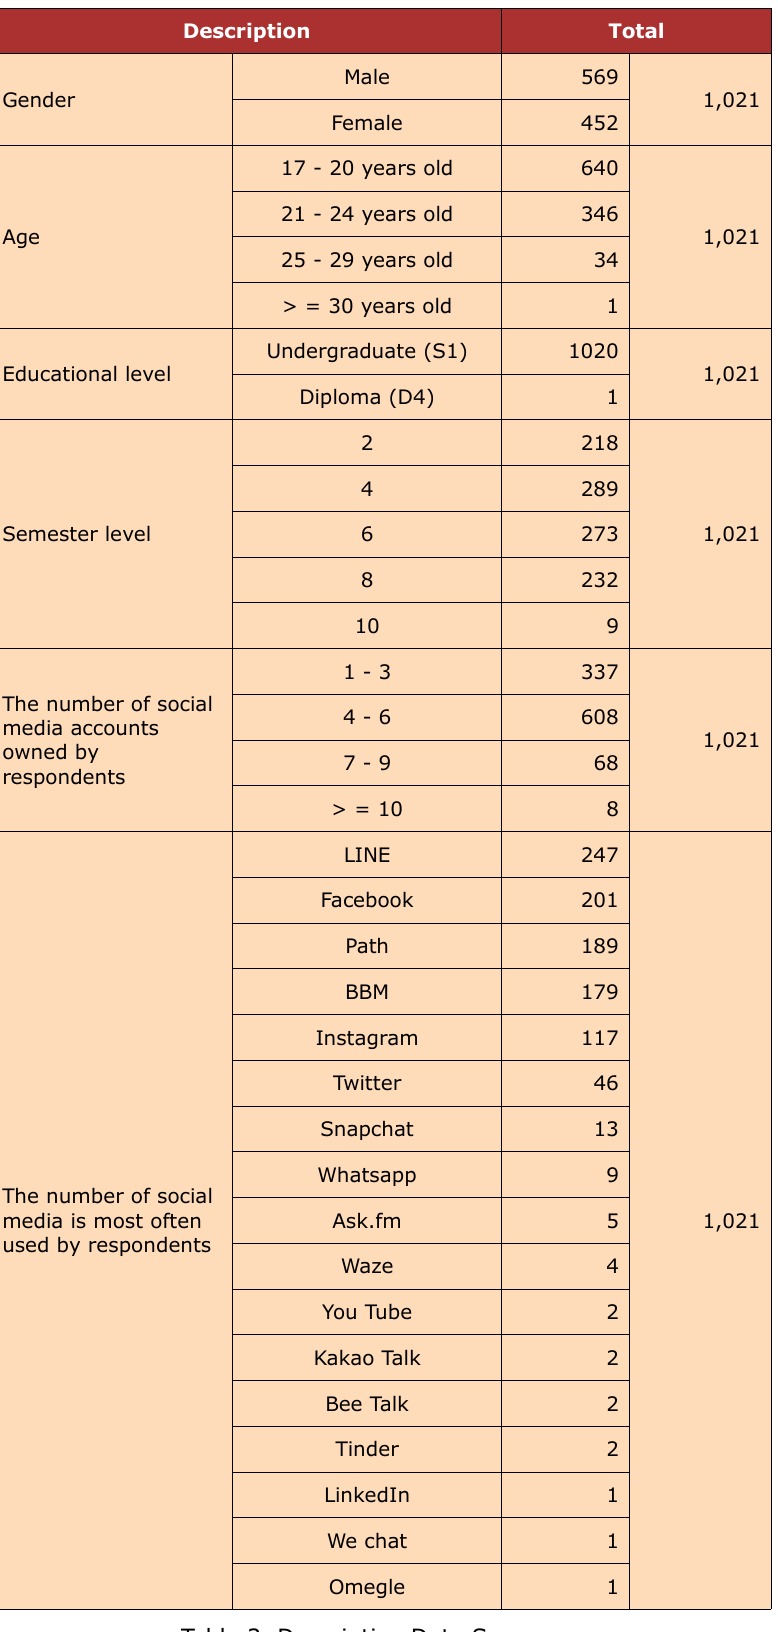
Table 2. Descriptive Data